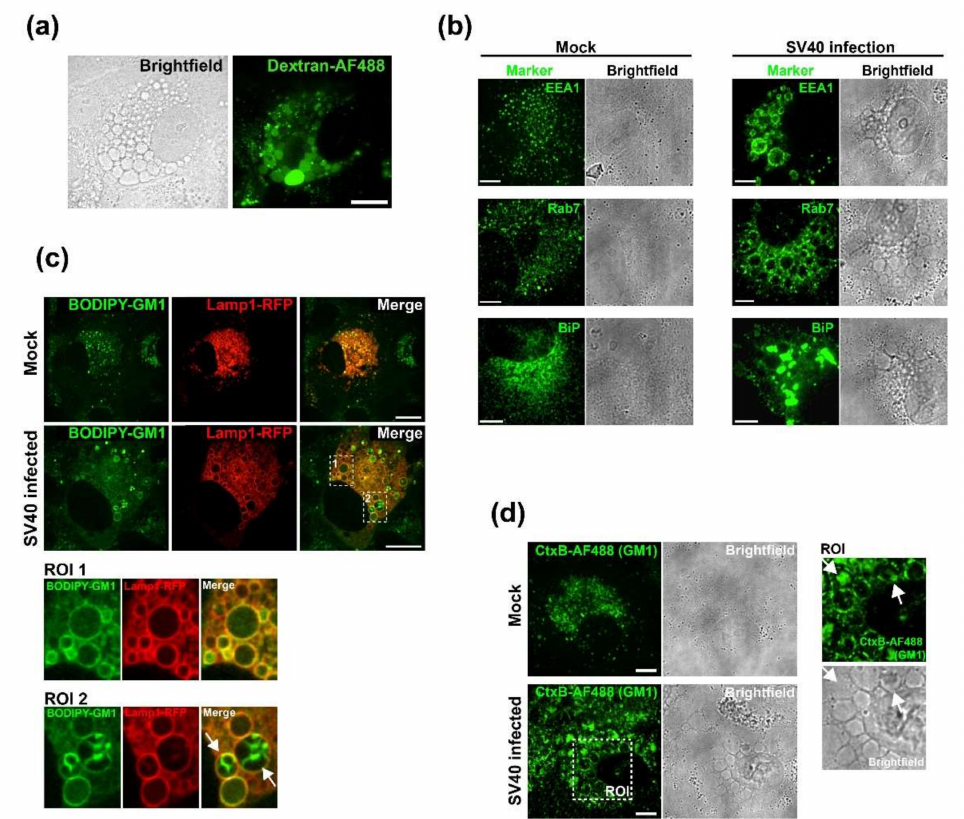
Figure 1. Characterization of SV40-induced vacuoles: ( a ) corresponding representative fluorescence and bright-field images of SV40-infected CV-1 cells 48 h.p.i. after incubation with medium containing fluorescent Dextran-AF488 (green), at scale bar 20 µ m; ( b ) immunostaining and brightfield images of mock-infected and SV40-infected CV-1 cells 48 h.p.i. with antibodies recognizing markers of early endosome (EEA1), late (Rab7) endosome, and the endoplasmic reticulum (BiP), as indicated, at scale bar 10 µ m; and ( c ) fluorescence microscopy images of mock-infected and SV40-infected CV-1 cells pulse-labeled 48 h.p.i. with fluorescent GM1 (BODIPY-GM1, green). CV-1 cells expressing Lamp1-RFP (red) were visualized by confocal microscopy. Arrows in regions of interest (ROIs) 1 and 2 highlight vacuoles in infected cells showing BODIPY-GM1 in the limiting membranes and interior of Lamp1-positive vacuoles, respectively. Single planes of z-stacks are shown at scale bar, 20 µ m. ( d ) Fluorescence confocal microscopy and brightfield images of endogenous GM1 stained with fluorescent cholera toxin B (CtxB-AF488) (green) in mock-infected and SV40-infected CV-1 cells 48 h.p.i.: single planes of z-stacks are shown. Arrows in ROIs depict CtxB-staining of vacuole